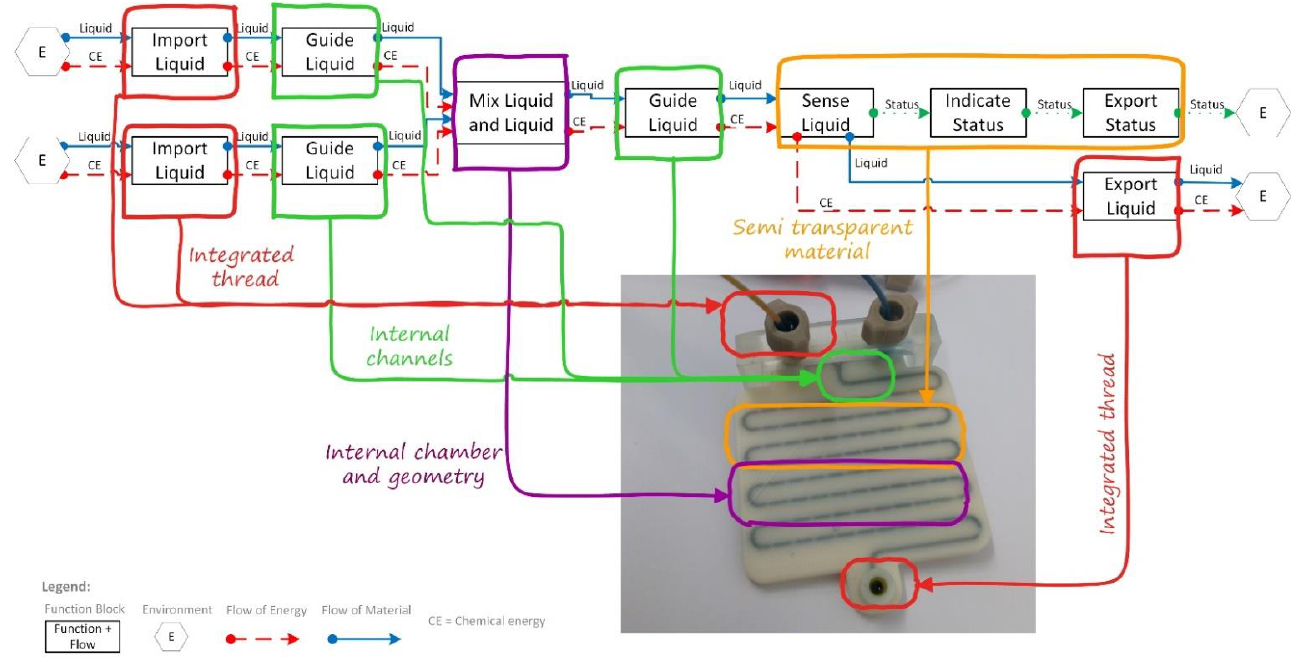
Figure 3. Example: Analysis of AM milireactor.